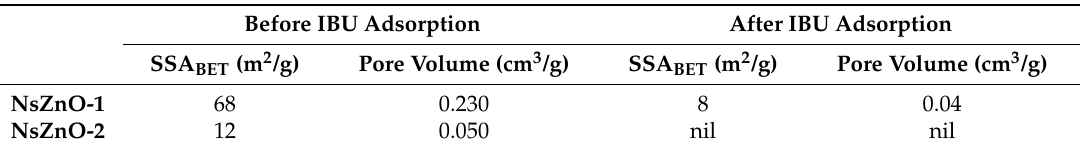
Table 1. Specific surface area (SSA) and pore volume values before and after the ibuprofen (IBU) adsorption by scCO 2 process.